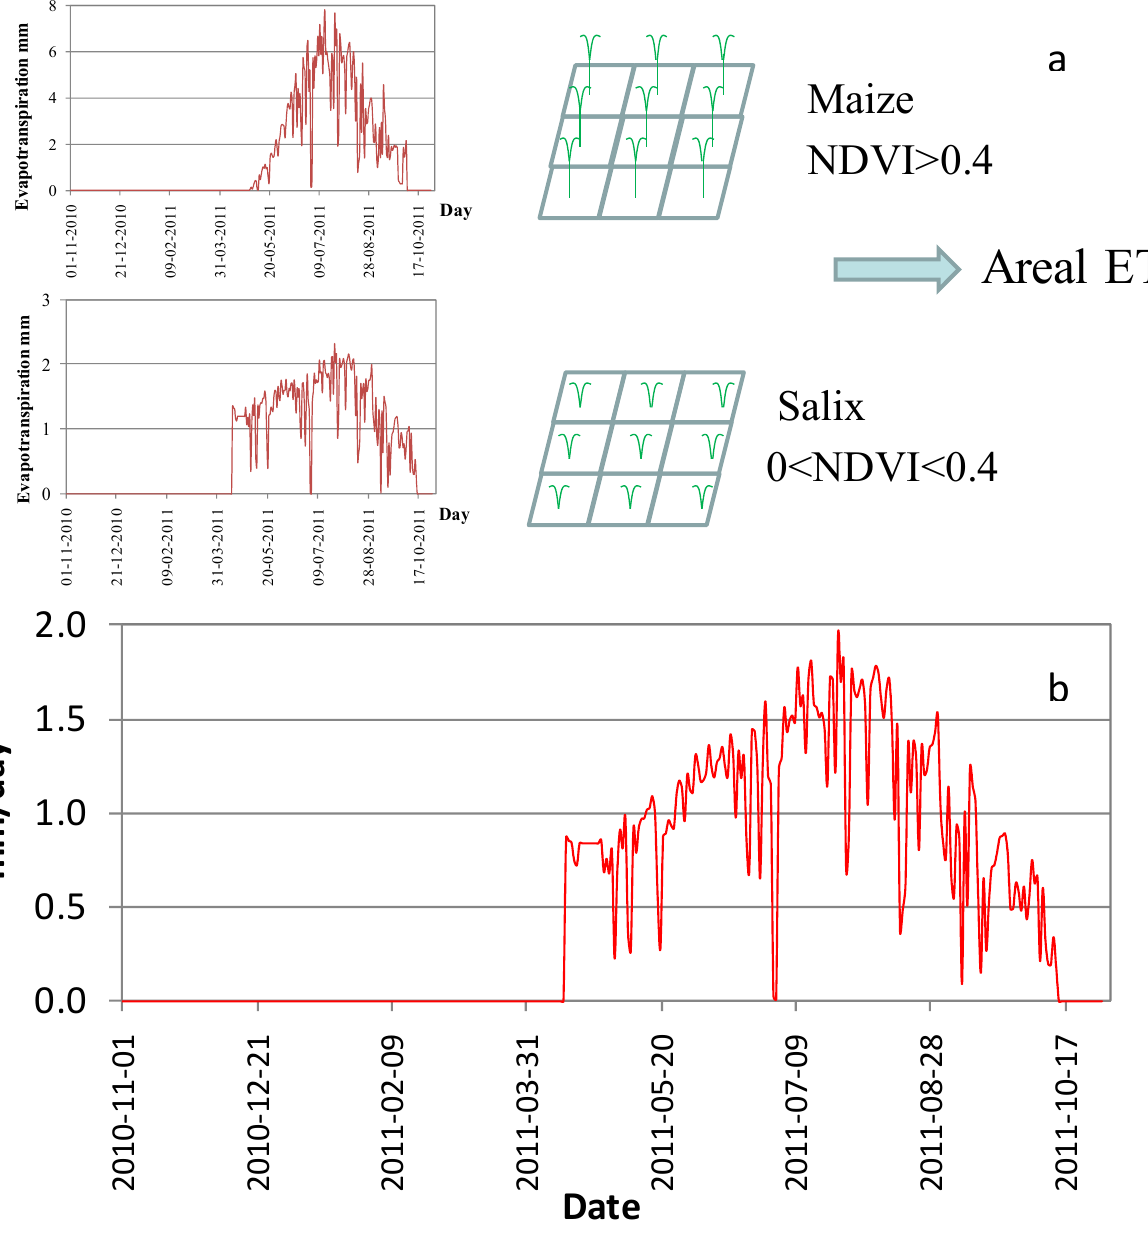
Figure 4. Up-scaling approach for areal evapotranspiration with sap flow measurements and NDVI values ( a ); and the estimated areal evapotranspiration ( b